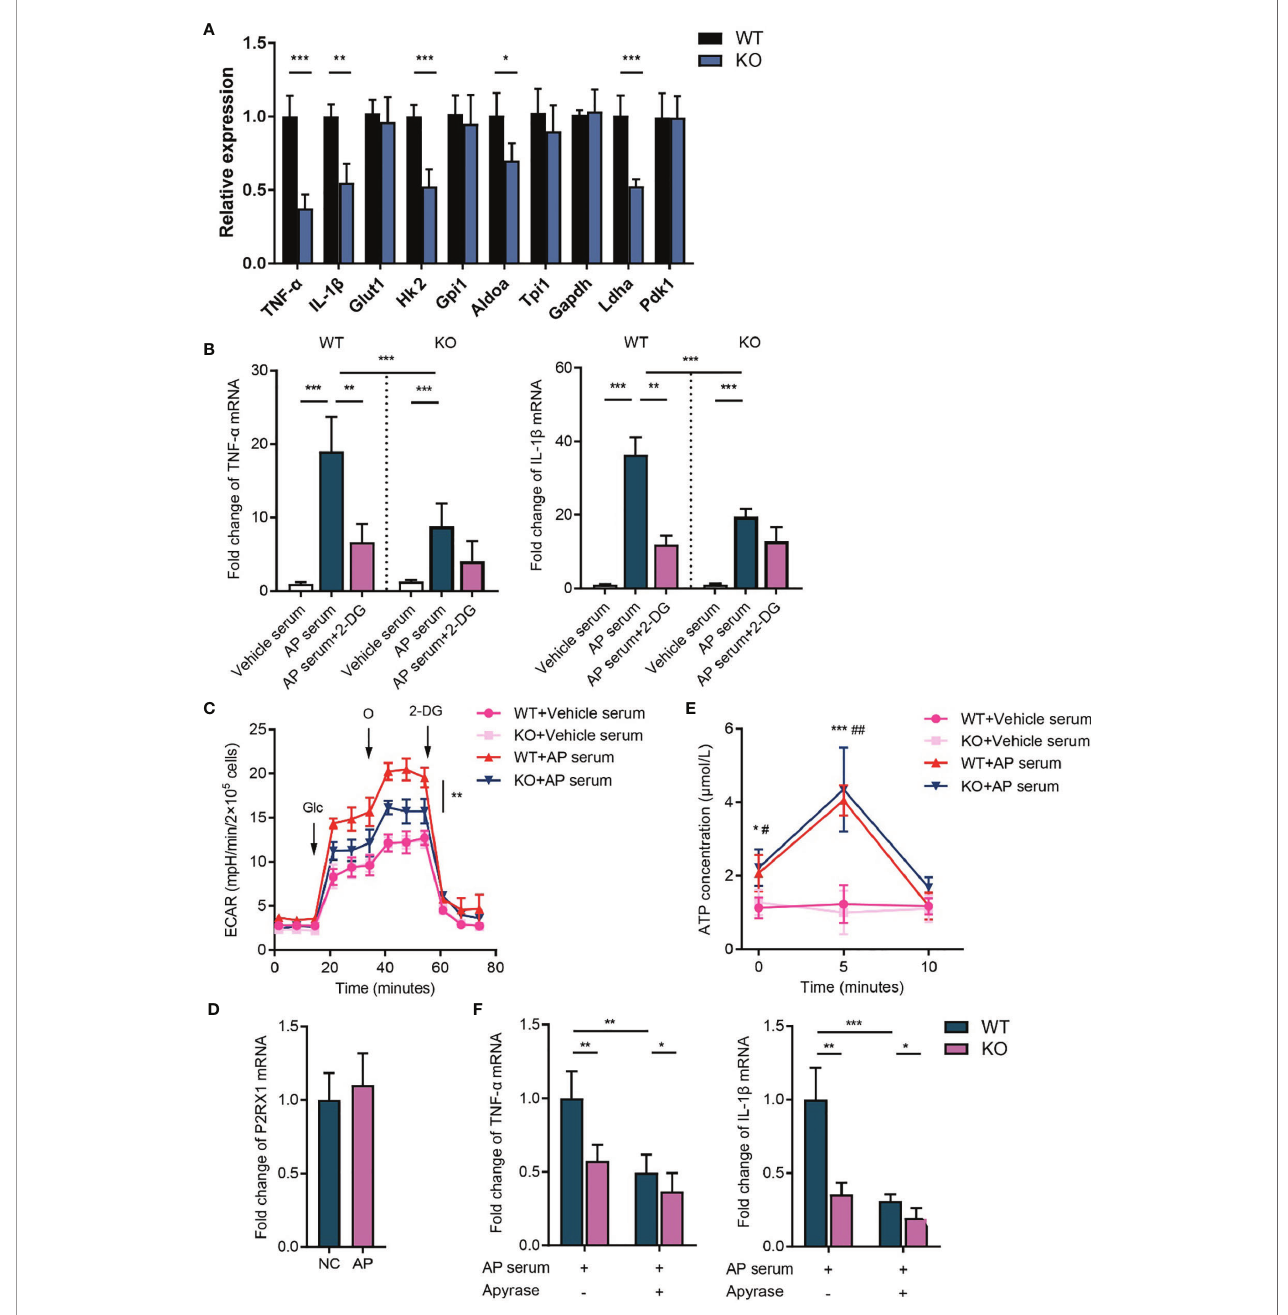
FIGURE 5 | P2RX1 is required for facilitating neutrophil ’ activation and glycolytic metabolism in acute pancreatitis. (A) Neutrophils were isolated from pancreas of WT or P2RX1-KO mice at 8 h after the fi rst administration of caerulein. Expressions of in fl ammatory cytokines and glycolytic metabolism genes were detected by RT- qPCR. 2 − dd Ct value was used for comparisons the fold change of mRNA expression to WT neutrophils. (B) Neutrophils were isolated from bone marrow of unstimulated WT or P2RX1-KO mice. Serum was used to stimulated neutrophils in the presence or absence of 2-DG for 6 h. In fl ammatory cytokines were measured by RT-qPCR. 2 − dd Ct value was used for comparisons the fold change of mRNA expression to vehicle serum-treated WT neutrophils. (C) Neutrophils were isolated from bone marrow of WT or P2RX1-KO mice. After stimulation with AP mice serum for 6 h, extracellular acid ratio (ECAR) was measured. (D) Pancreas P2RX1 expression in NC mice or AP mice were determined by RT-qPCR. 2 − dd Ct value was used for comparisons of the fold change of mRNA expression to NC pancreas. (E) Neutrophils were isolated from bone marrow of WT or P2RX1-KO mice and stimulated with AP serum. Extracellular ATP was detected in indicated time points. (F) Neutrophils were isolated from bone marrow of WT or P2RX1-KO mice and stimulated with AP serum with or without apyrase. In fl ammatory cytokines were measured by RT-qPCR. 2 − dd Ct value was used for comparisons of the fold change of mRNA expression. Statistics were calculated using Student ’ s t test (A, E, F) , or one-way ANOVA with Tukey post-tests (B, C) . * P < 0.05, ** P < 0.01, *** p <